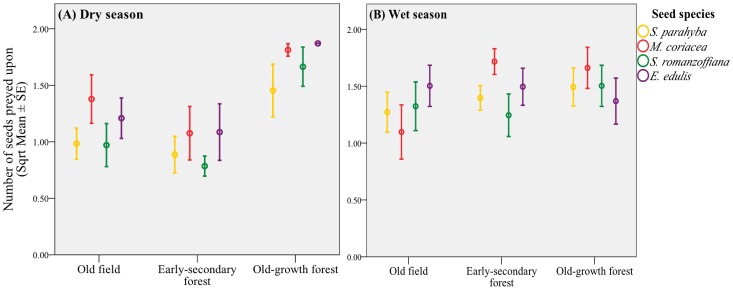
Average seed predation (square-root transformed) per seed species among habitats during the (A) dry and (B) wet seasons.Error bars indicate the standard error (SE) of the means.